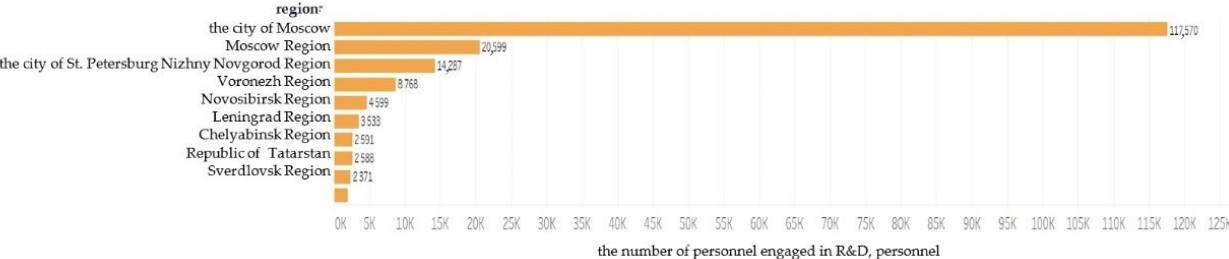
Figure 4. Size of incoming slacks according to the indicator of internal costs for R&D (vtz).